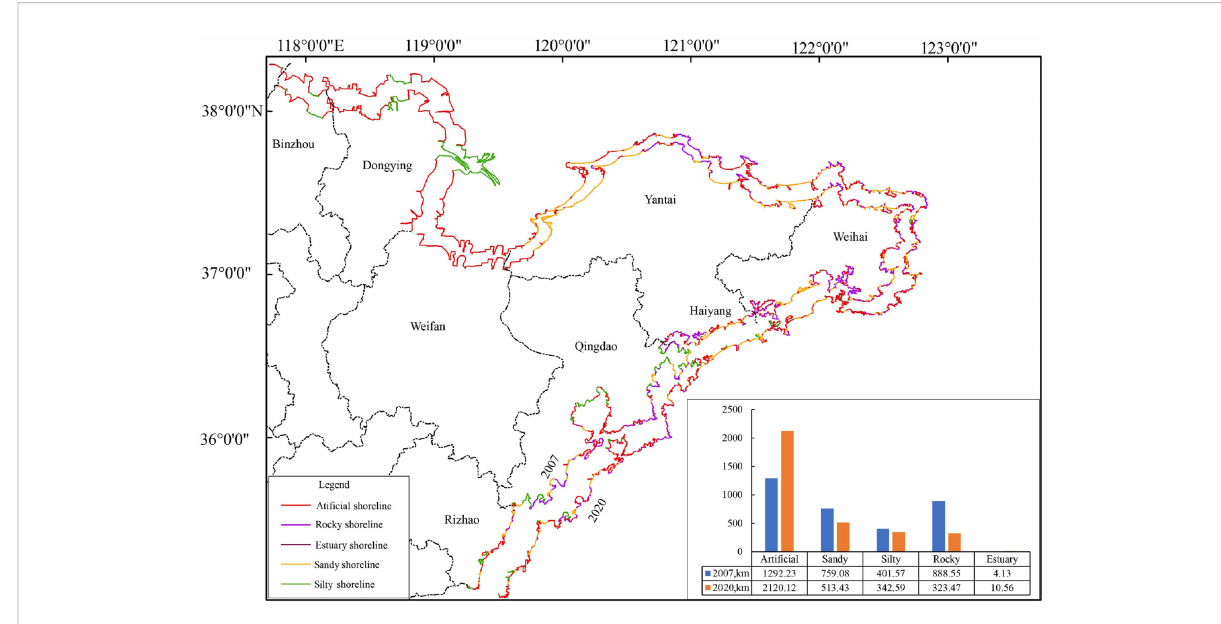
FIGURE 3 Type-classi fi ed shoreline lengths of Shandong in 2007 and